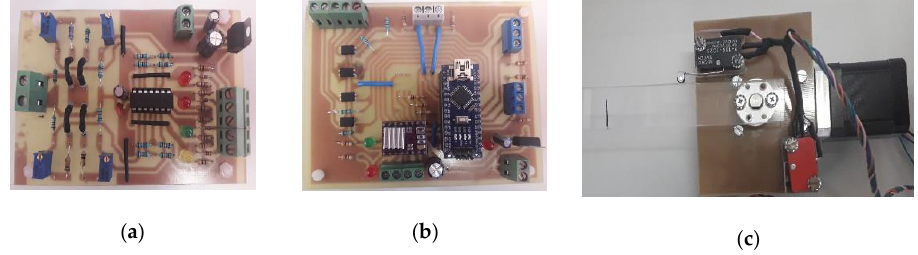
Figure 12. Developed elements for the stepper motor angular application: ( a ) input voltage level